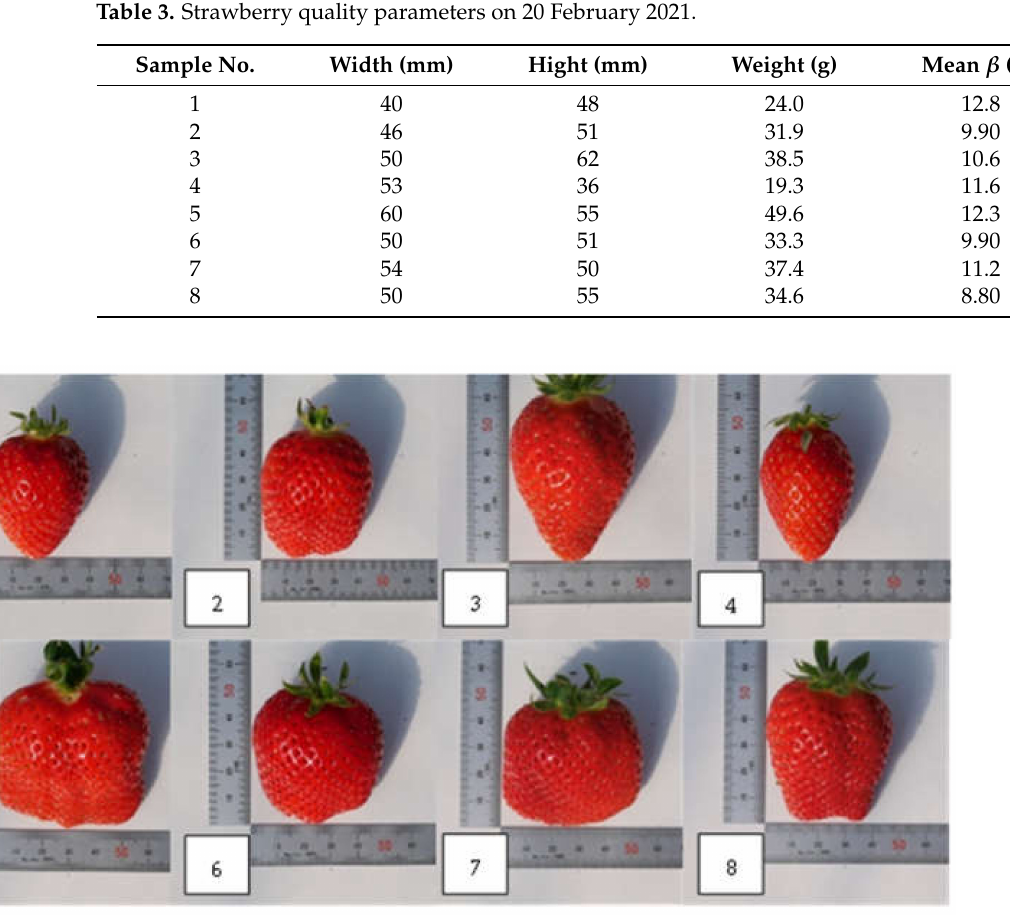
Figure 12. Strawberry fruits harvested on 20 February